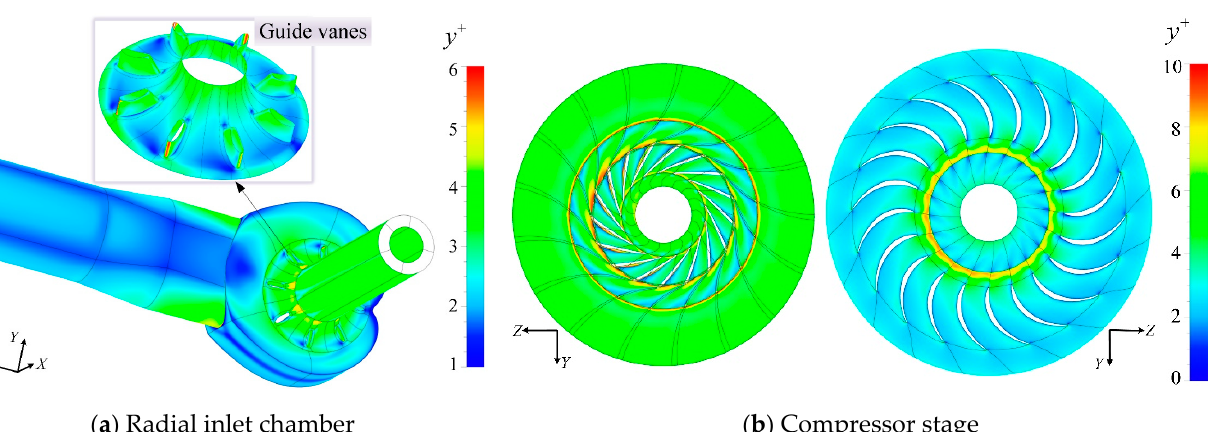
Figure 4. Computational grids for different components of the computational fluid dynamics (CFD) models.